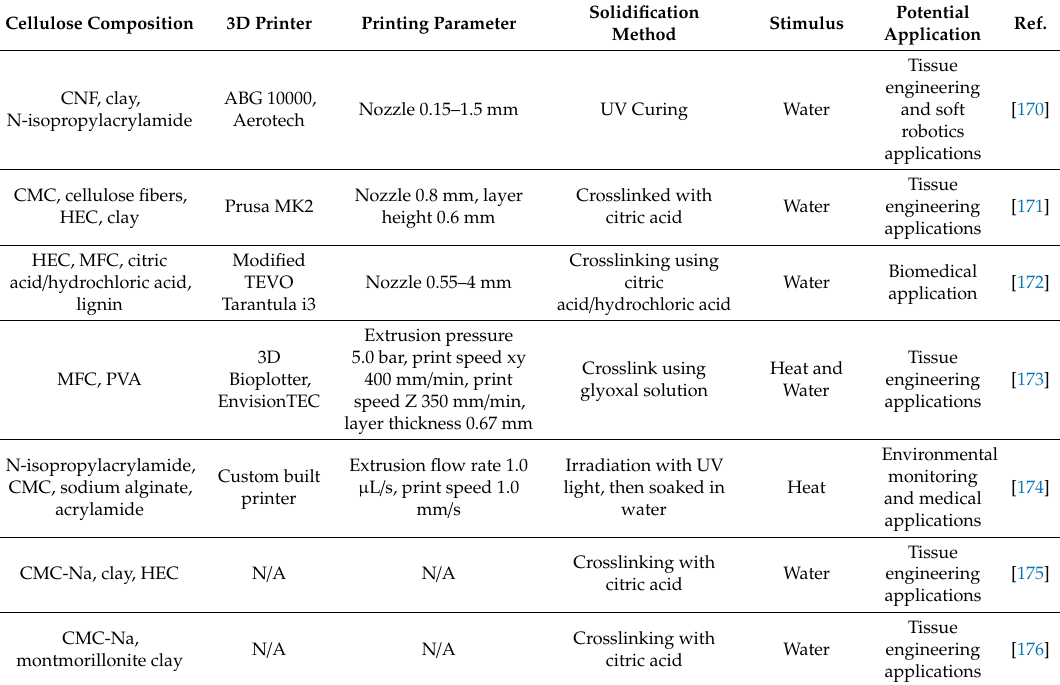
Table 6. Review of 4D printed cellulose based materials using LDM